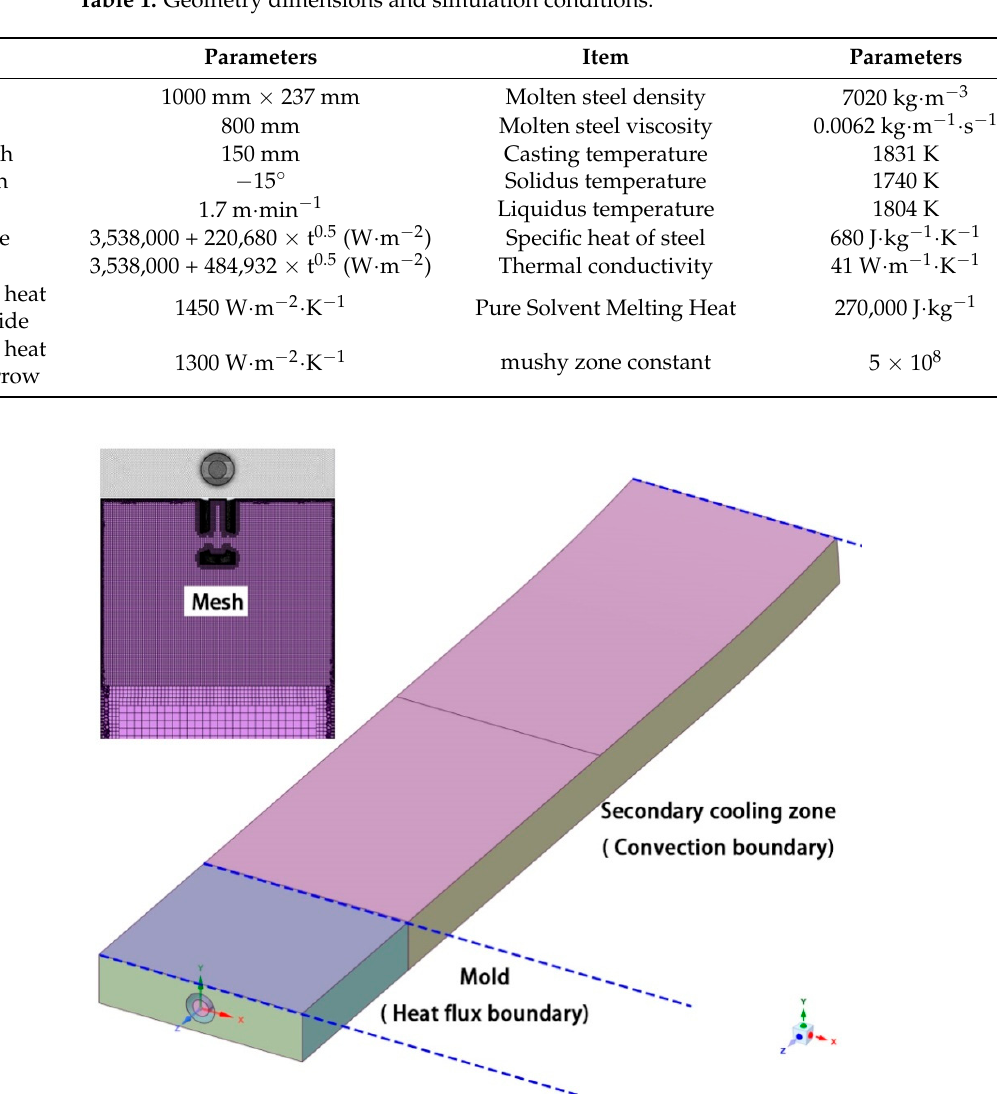
Figure 4. Geometric model of the computational domain and mesh.